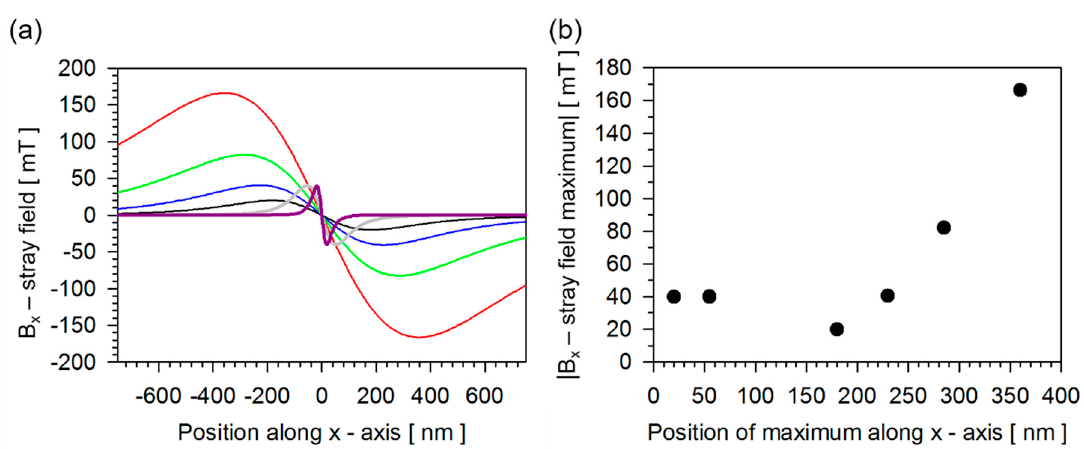
Figure 9. B x —component of the dipolar stray field range of the particles with magnetic parameters provided in Figure 8: in black—motif, in blue 2xmotif, in green 4xmotif, in red 8xmotif, in grey Ni 50 Mn 32.5 Ga 17.5 and in dark magenta Co 2 MnSi; ( a ) B x component of the stray field along the x -direction of a particle positioned 10 nm above the surface of a magnetoresistive sensor; ( b ) Position and amplitude of the maxima of the B x component of the stray fields imaged in ( a ). The dipolar stray field has been calculated applying [47] assuming a fully saturated particle in z -direction.